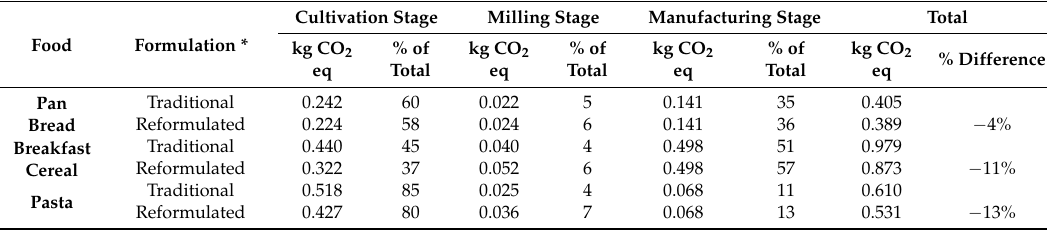
Table 4. Greenhouse gas emissions associated with each stage of the production of 1 kg of traditional and reformulated bread, breakfast cereals, and